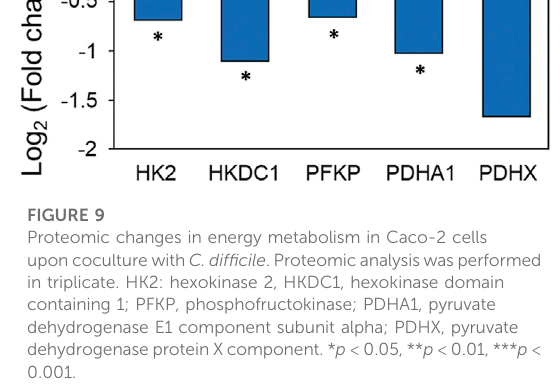
TABLE 2 The metabolomic changes in Caco-2 cells during coculture with C. dif fi cile . Metabolomic analysis was performed in quadruplicate.